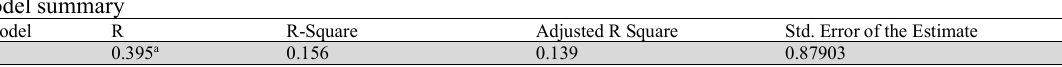
Model summary Model R R-Square Adjusted R Square Std. Error of the Estimate 1